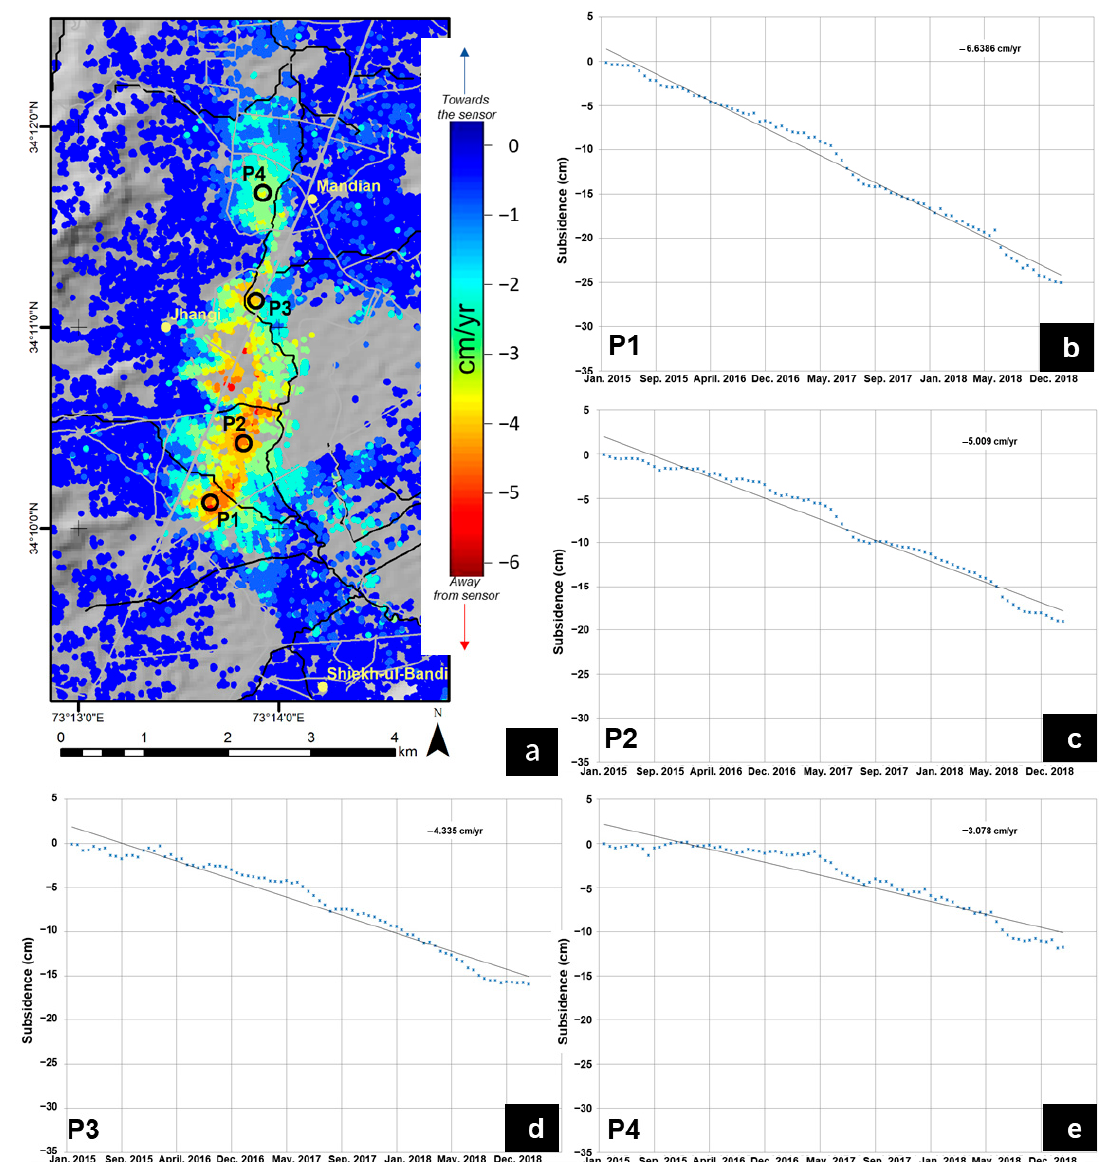
Figure 8. Time series evaluation of averaged LOS deformation presented using ascending data: ( a ) location of PSs, ( b ) P1, ( c ) P2, ( d ) P3, and ( e ) P4.